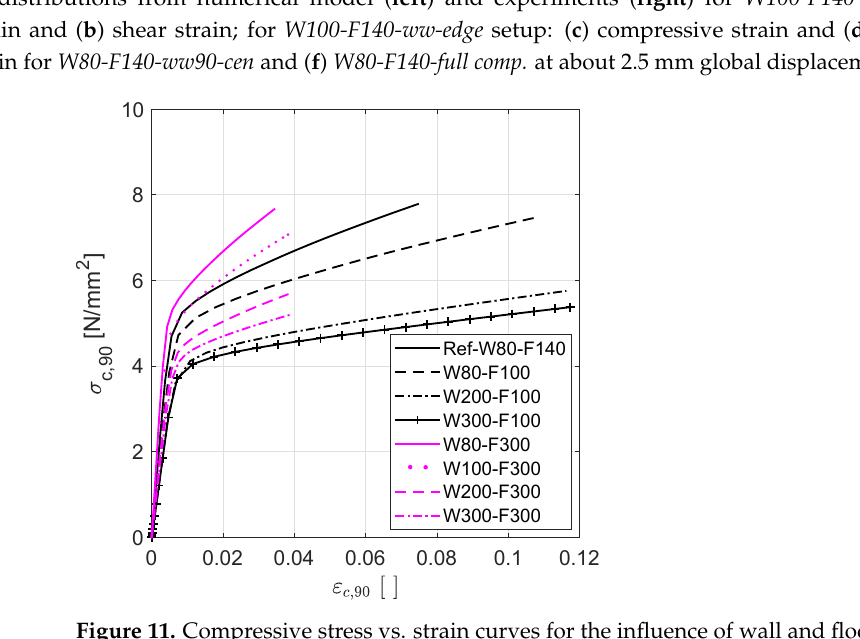
Figure 11. Compressive stress vs. strain curves for the influence of wall and floor